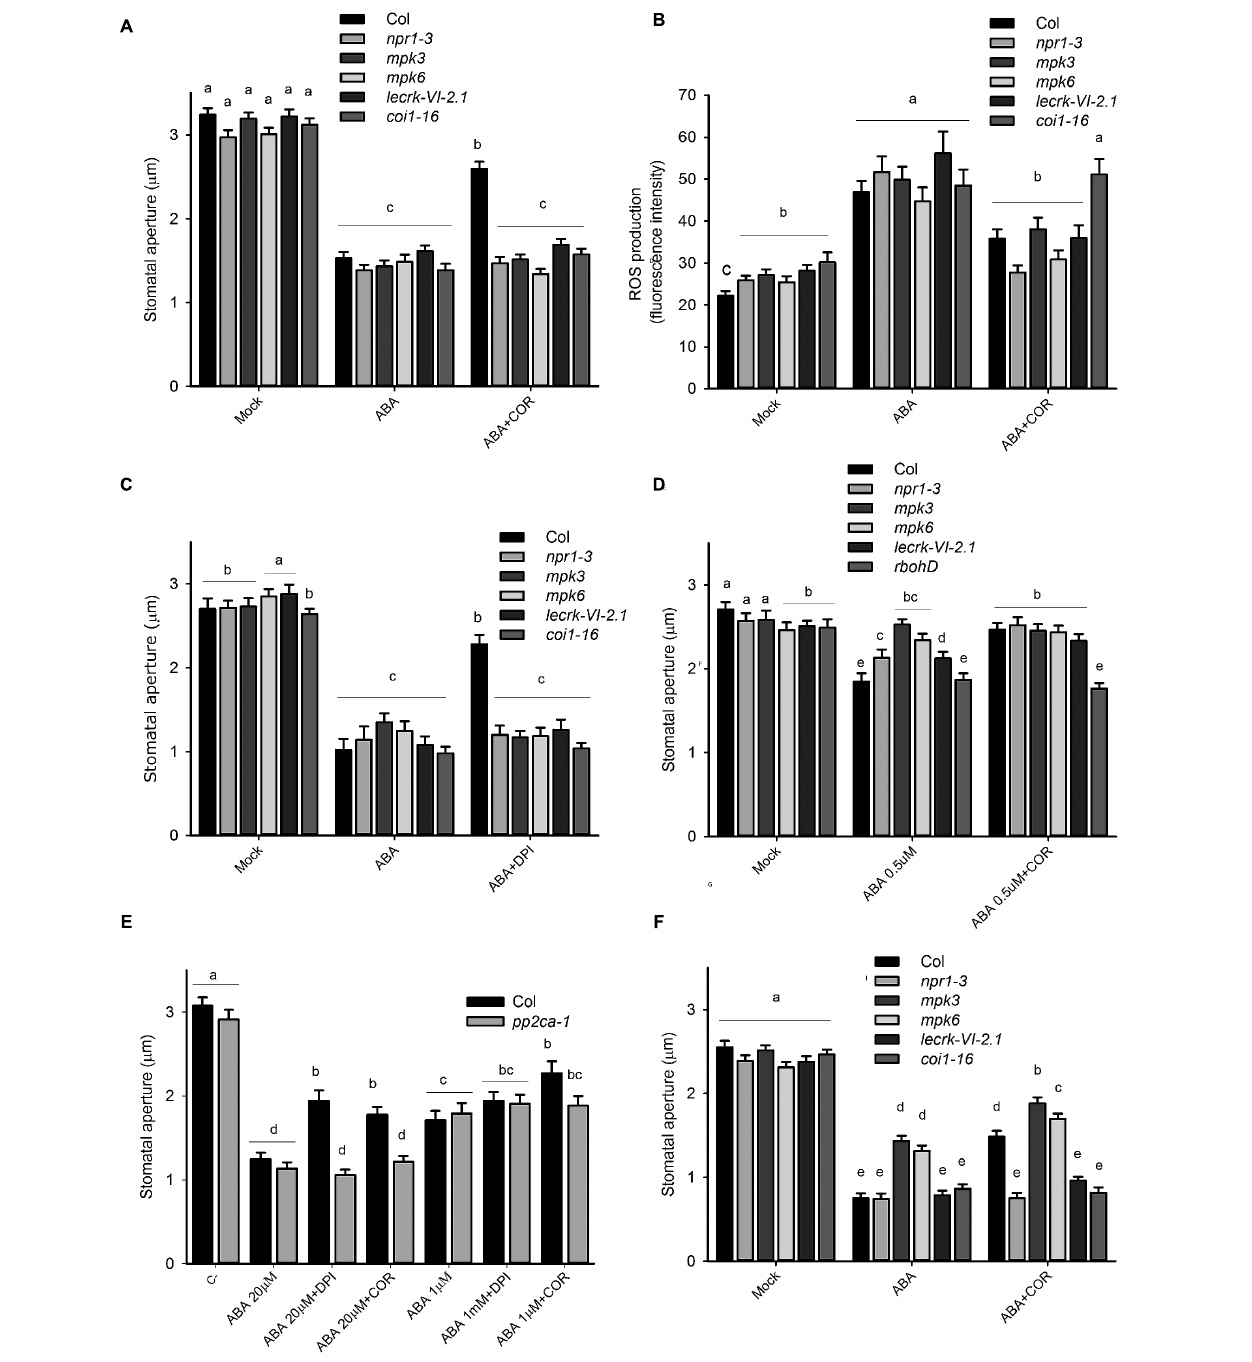
FIGURE 4 | Several mutants display reduced stomatal sensitivity to coronatine and DPI. (A) Coronatine (COR, 1.56 µ M) failed to inhibit stomatal closure by ABA (20 µ M) in mpk3 , mpk6 , npr1-3 and lecrkVI-2.1 , and coi1-16 mutants. (B) Coronatine (COR, 1.56 µ M) inhibited ABA (20 µ M)-induced ROS production in guard cells of mpk3 , mpk6 , npr1-3, and lecrkVI-2-1 mutants. (C) Treatment with DPI (20 µ M) failed to interfere with stomatal closure induced by ABA (20 µ M) in npr1-3 , mpk3 , mpk6 , and lecrkVI-2-1 mutants but not in wild type Col. (D) mpk3, mpk6 , npr1-3, and lecrkVI.2-1 showed different degrees of insensitivity to ABA (0.5 µ M). At this lower ABA concentration, coronatine (COR, 1.56 µ M) prevented stomatal closure in npr1-3 and lecrkVI.2-1 mutants. (E) pp2ca-1 mutant is insensitive to coronatine (COR, 1.56 µ M) and DPI (20 µ M) in stomatal closure induced by 20 µ M ABA. (F) Coronatine (COR, 1.56 µ M) partially relieved inhibition of light-induced stomatal opening by ABA (20 µ M) in mpk3 , mpk6 , but not in npr1-3 and lecrkVI-2-1 mutants. DPI was added to the incubation buffer 10 min prior to ABA (20 µ M). In (A,B) and (D–F) coronatine was added 10 min before ABA. In all cases stomatal apertures were measured 1.5 h after treatments. Different letters indicate significant differences at p < 0.05 in (A–F ; two-way ANOVA). Error bars represent SE from two independent trials, n = 40 per trial (A–F) .